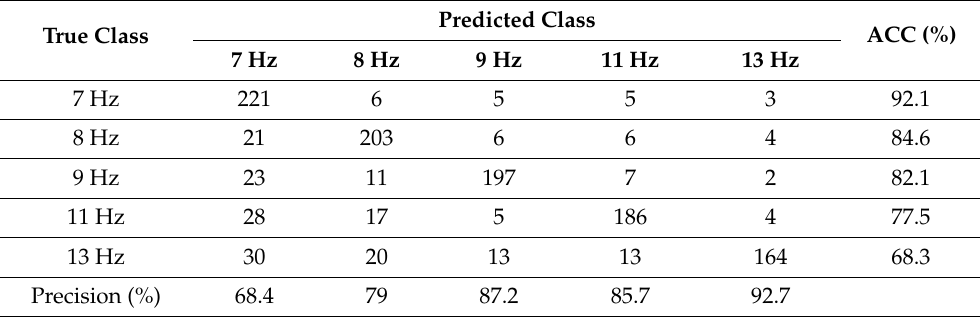
Table 6. The confusion matrix for the SSVEP recognition results using MSI classifier for the map test in the first experiment (Scenario